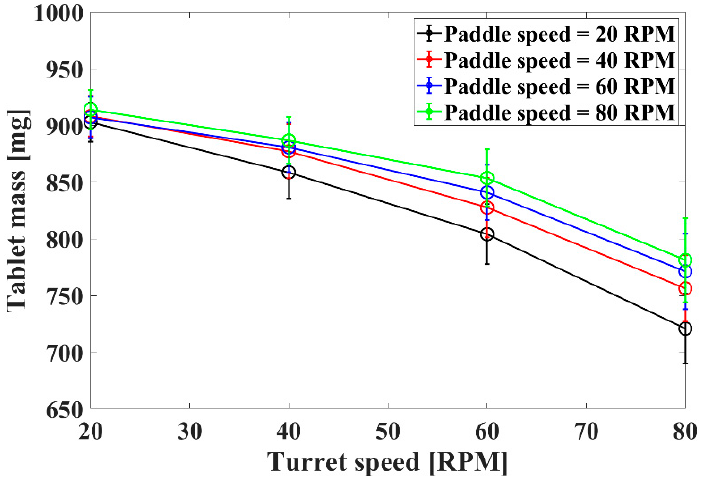
Figure 13. Effect of paddle speed and turret speed on mean tablet mass. Tablet mass decreases with increasing turret speed, and paddle speed begins to affect tablet mass at larger turret speeds.